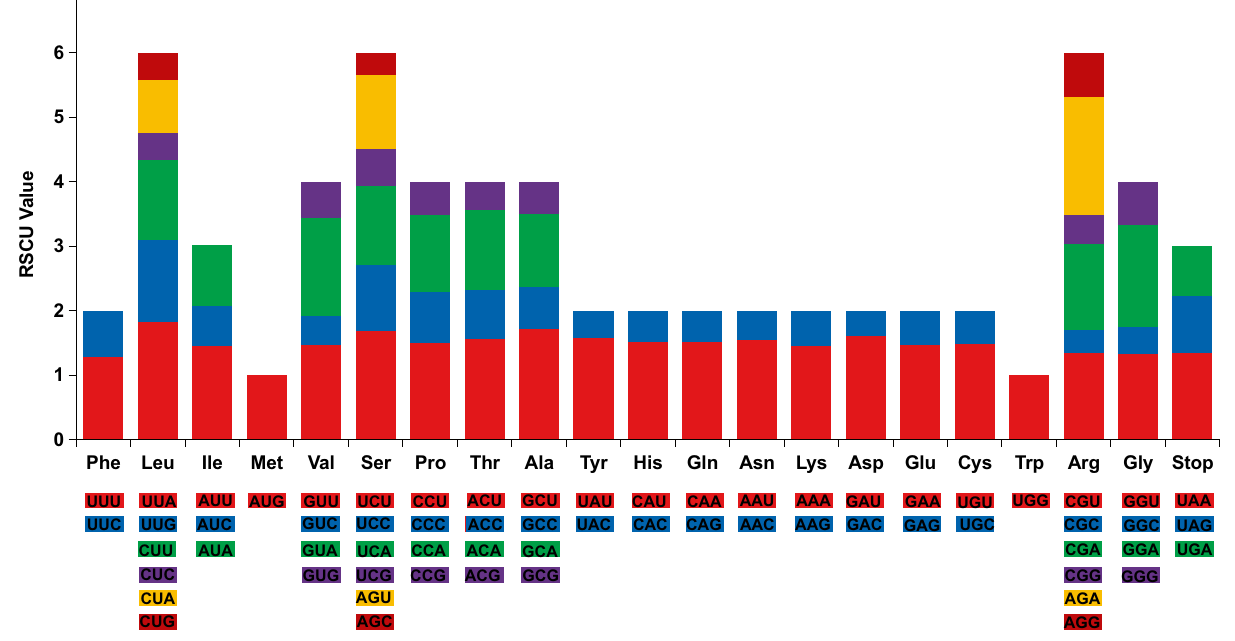
Figure 3. Relative synonymous codon usage (RSCU) of 20 amino acids and stop codons in all protein-coding genes of the chloroplast genome of A. episcopale.